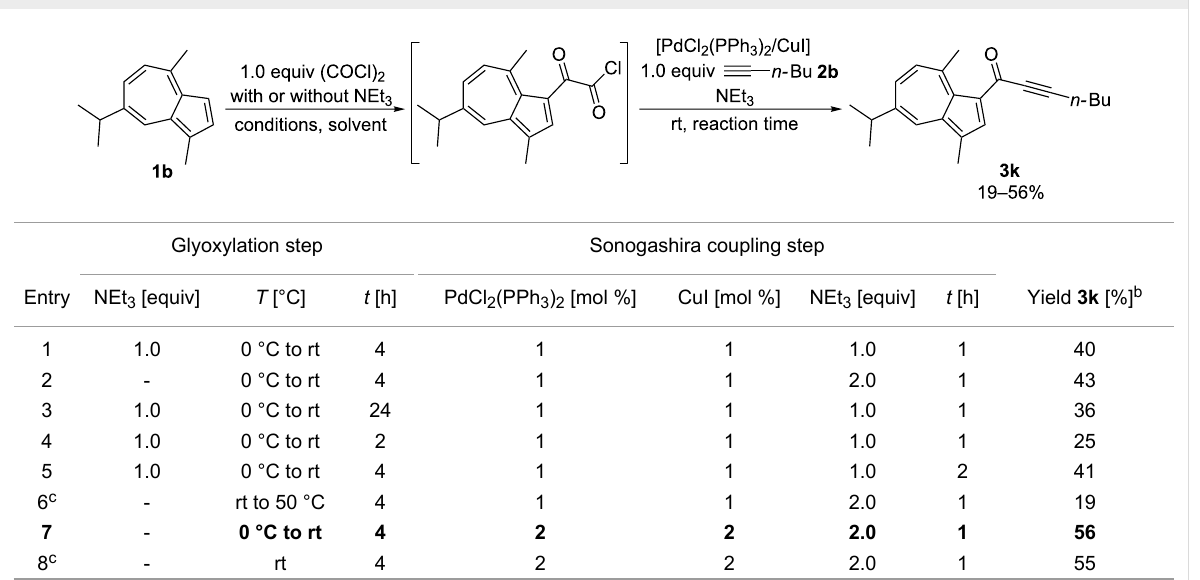
Table 1: Optimization studies for the synthesis of ynone 3k .